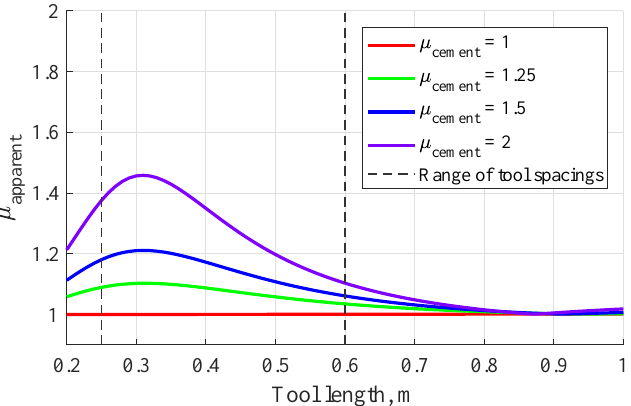
Figure 5. Apparent magnetic permeability vs. tool length at the frequency of 1